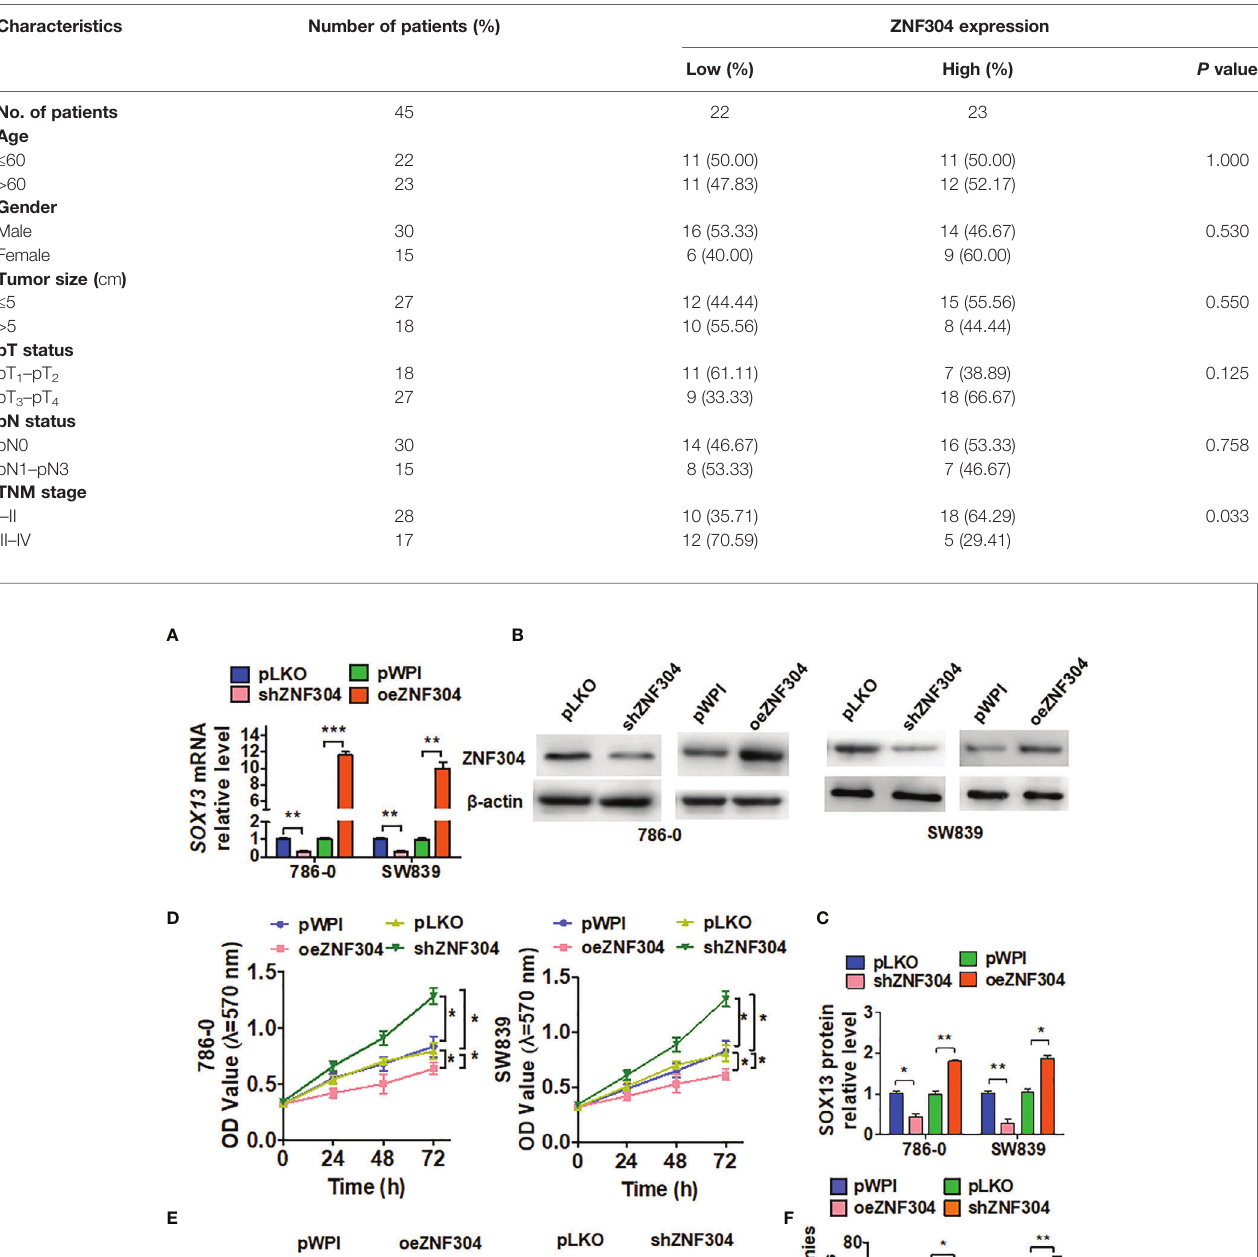
TABLE 1 | Clinicopathological characteristics.